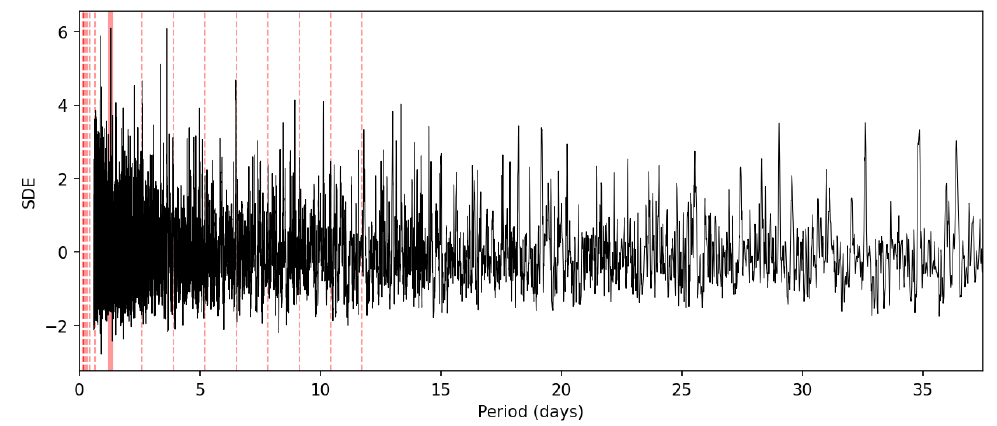
Figure 7. SDE from the analysis with TLS. No clear peaks are shown, which means that it does not present transit-like